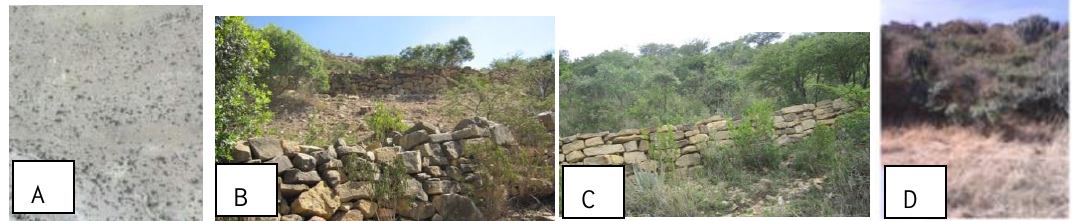
Figure 3. Major soil and water conservation measures in one site ( A ) non-conserved grazing land; ( B ): terraces in grazed land; ( C ) exclosure + terrace; and ( D ) exclosure alone in one site